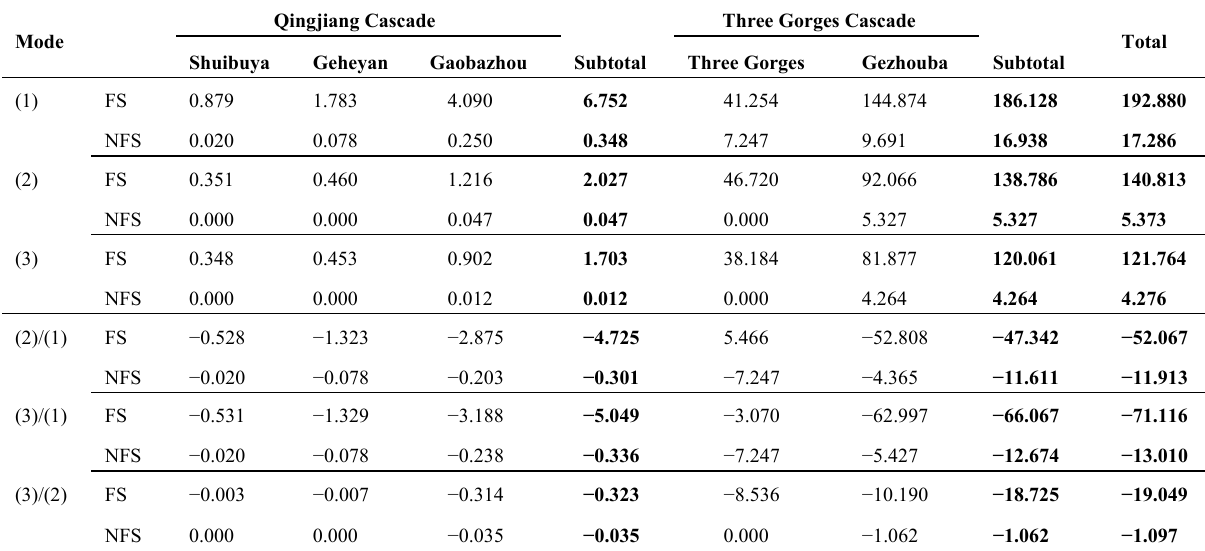
Table 4. Estimated spilled water (billion m 3 ) by objective function of maximum hydropower generation during flood season and non-flood season.